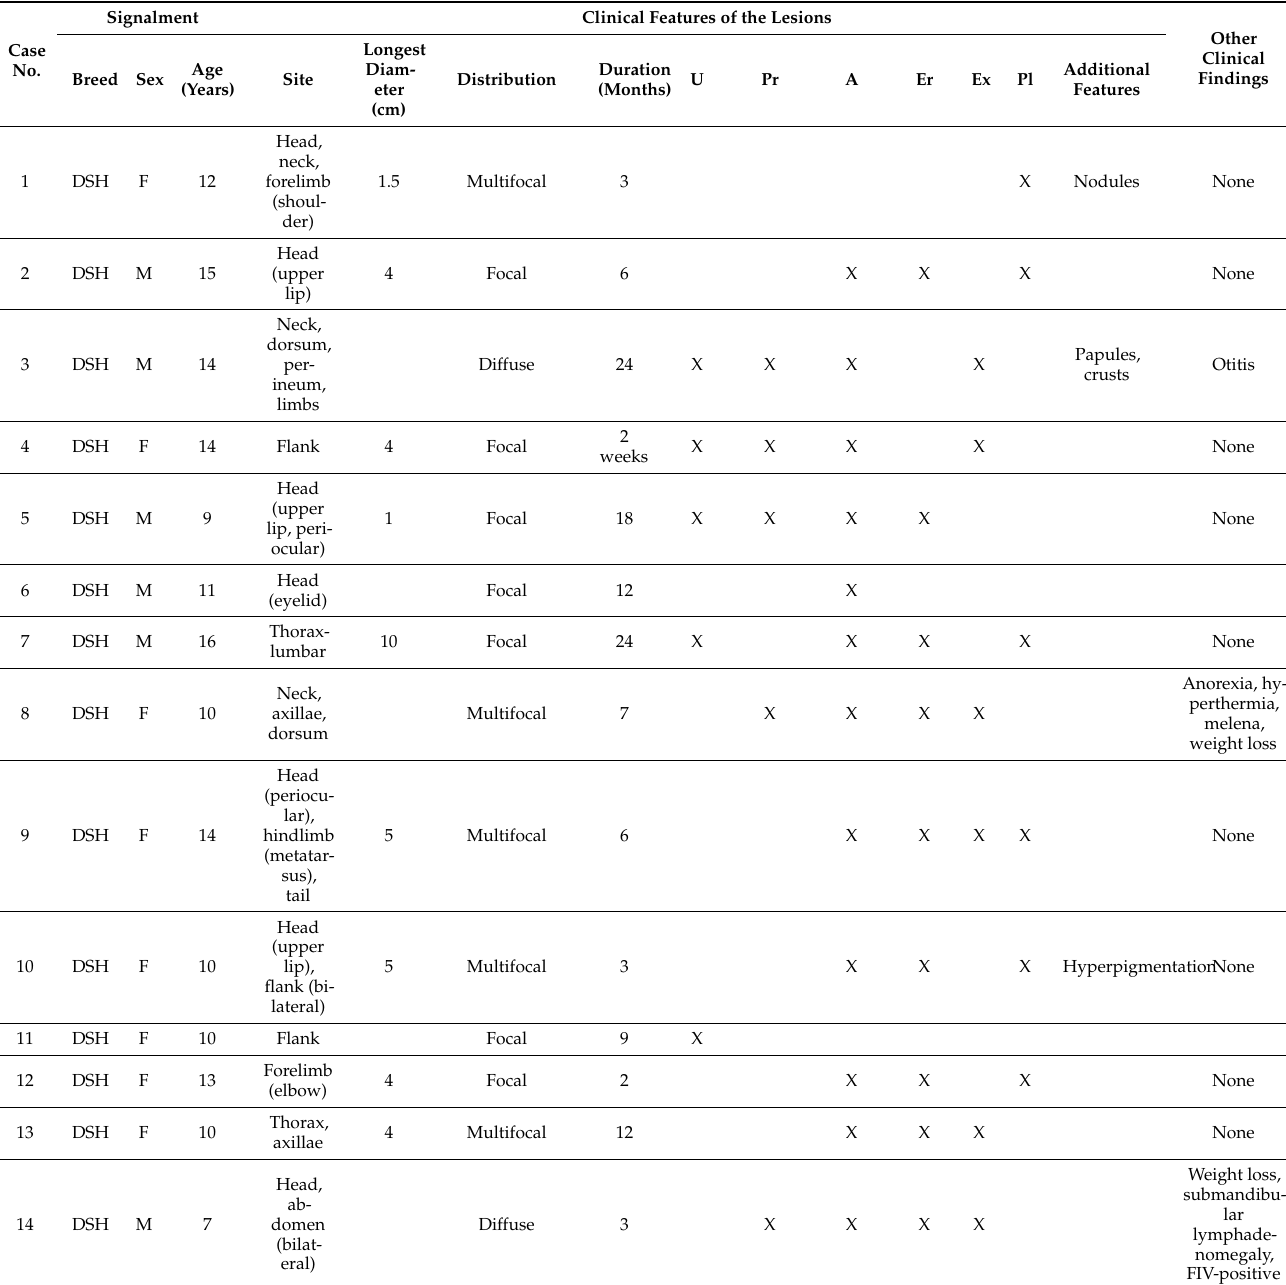
Table 1. Signalment and clinical findings in cats with cutaneous